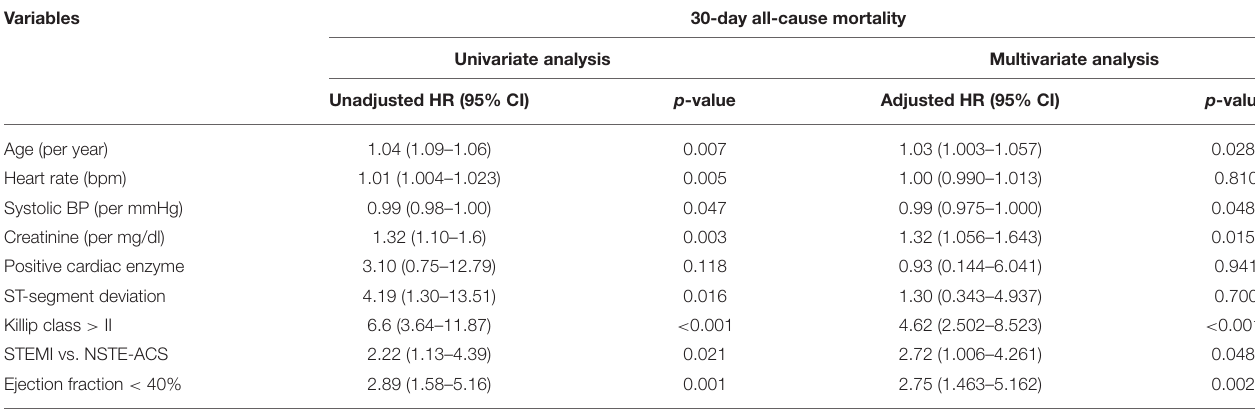
TABLE 4 | Predictors of 30-day all-cause mortality among patients admitted with ACS. Variables 30-day all-cause mortality Univariate analysis Multivariate